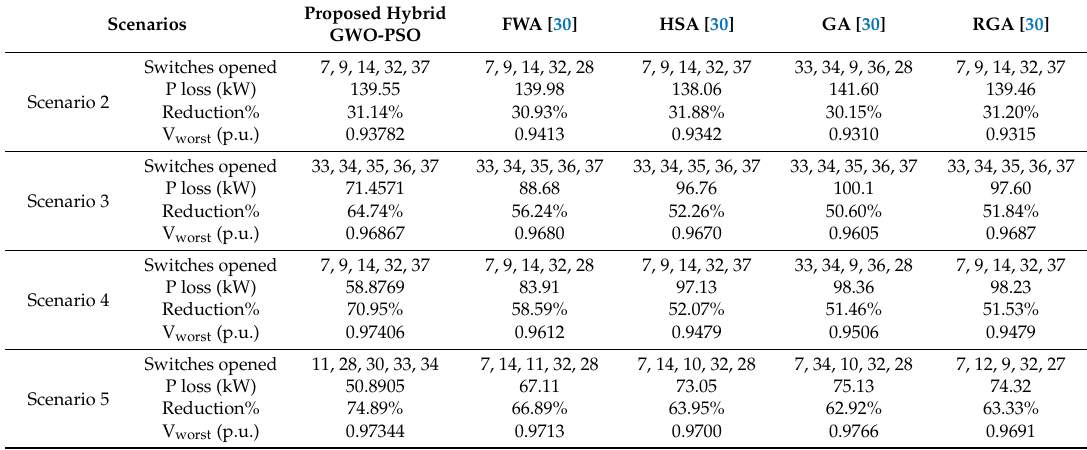
Table 4. Comparison of methods performance for the 33-bus system.